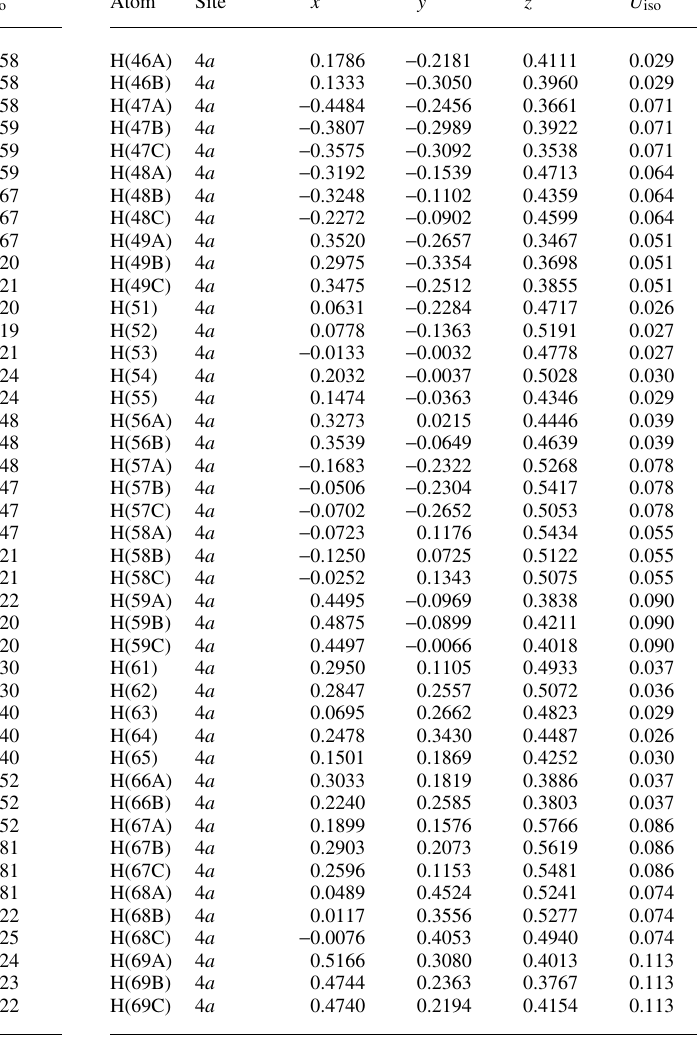
Table 3. Atomic coordinates and displacement parameters (in Å 2 )